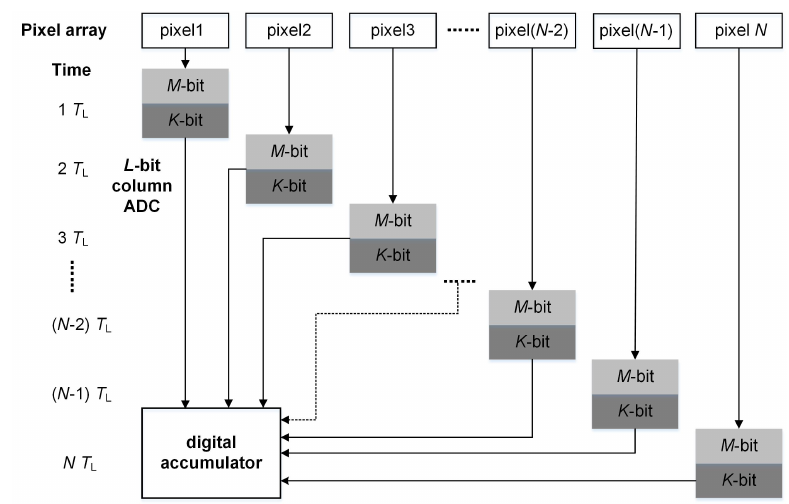
Figure 1. Traditional digital domain accumulation scheme.